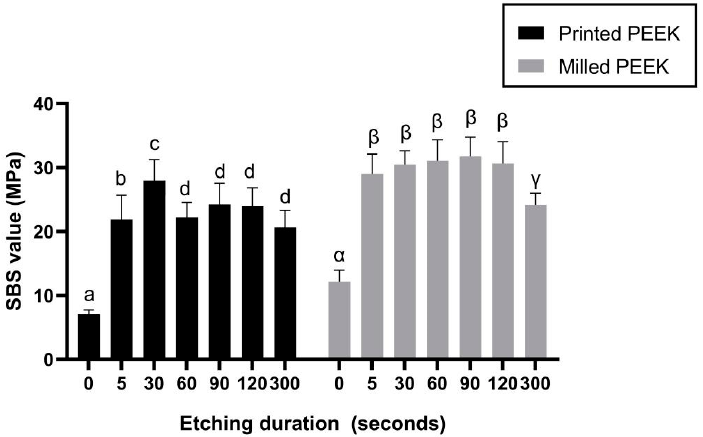
Figure 6. The mean ± SD of SBS values after different etching durations. Within the same color columns, different letters (a, b, c, α , β , and γ ) indicate subgroups that are statistically different ( p < 0.05). SBS, shear bond strength.